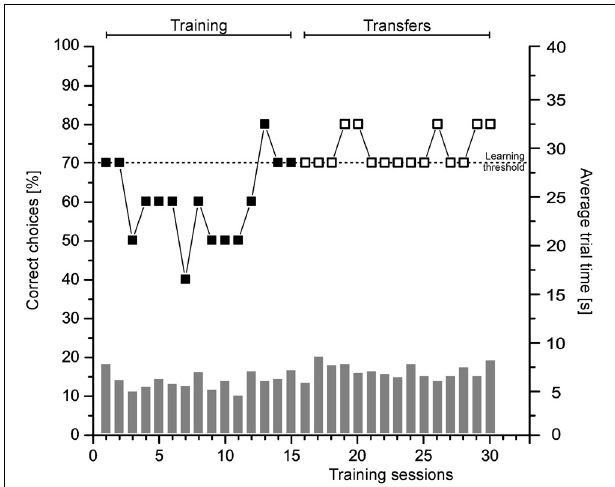
FIGURE 10 | Müller-Lyer deception. Shown is the performance of Shark 5 as the percentage of correct choices per session (symbolized by boxes; left ordinate) as well as the average trial time (s) per session (symbolized by gray bars; right ordinate) per phase until the learning criterion was reached.